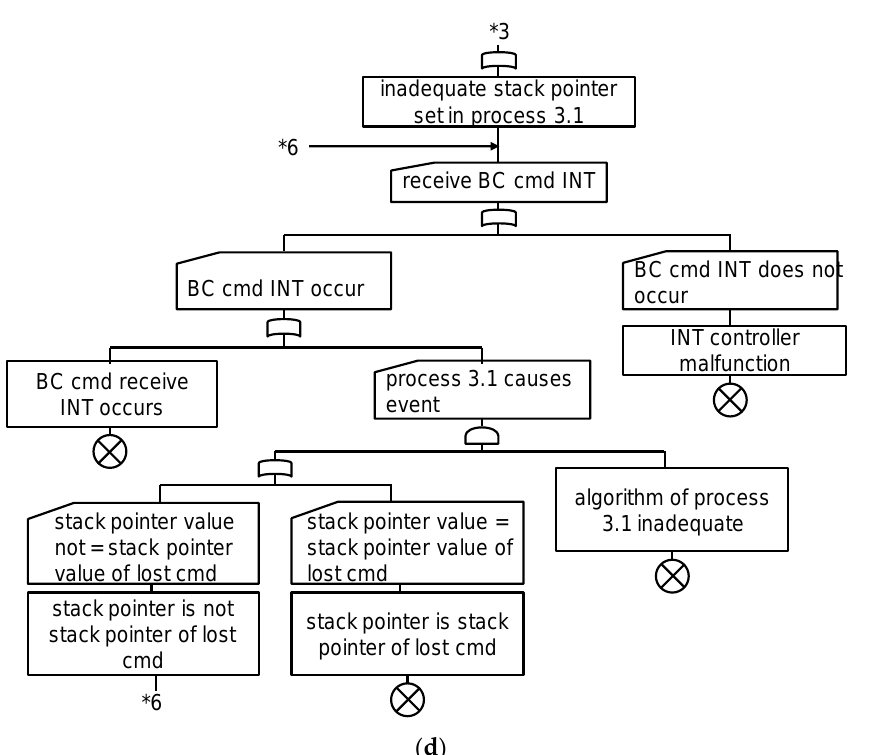
Figure 11. ( a ). Developed FT — Outline of FT. ( b ) FT — Detail of (C) Descriptor Value Is Incorrect. ( c ) Developed FT — Detail of (D) Data Block Value Is Incorrect. ( d ) Developed FT — Detail of (B) Stack Pointer Value Is Incorrect.